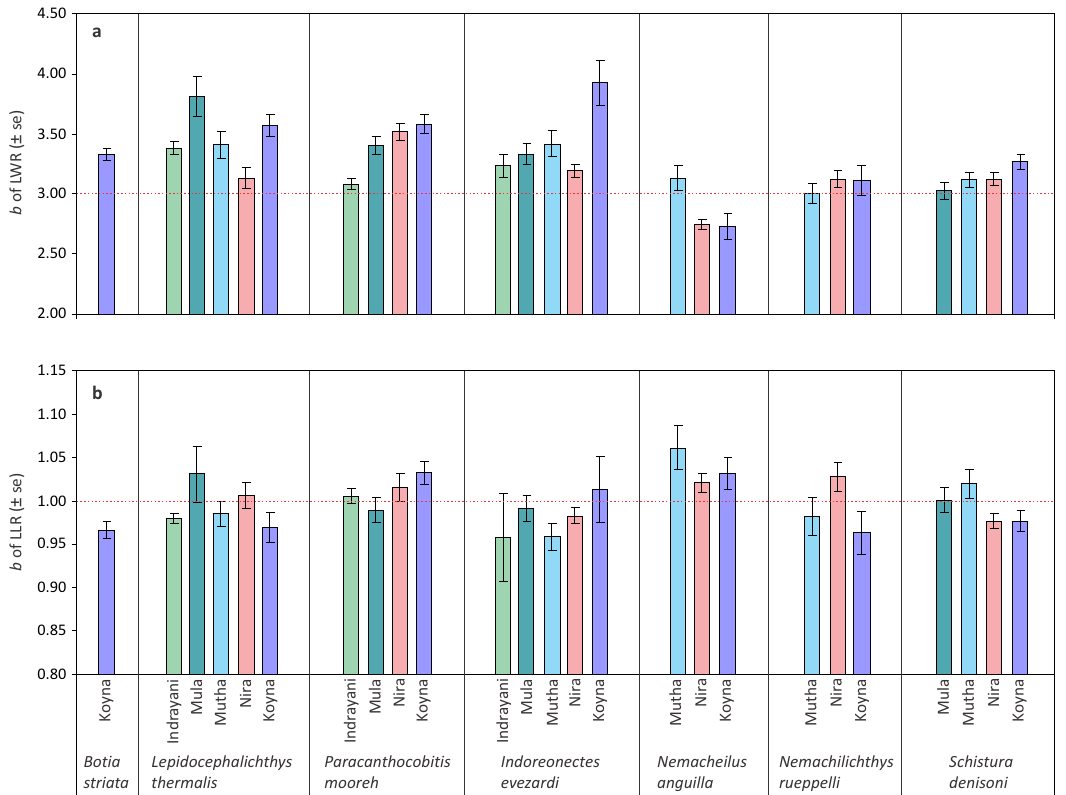
Figure 2. Species and river wise variation in the b value of (a) LWR and (b) LLR. Red dashed lines are expected values from isometric